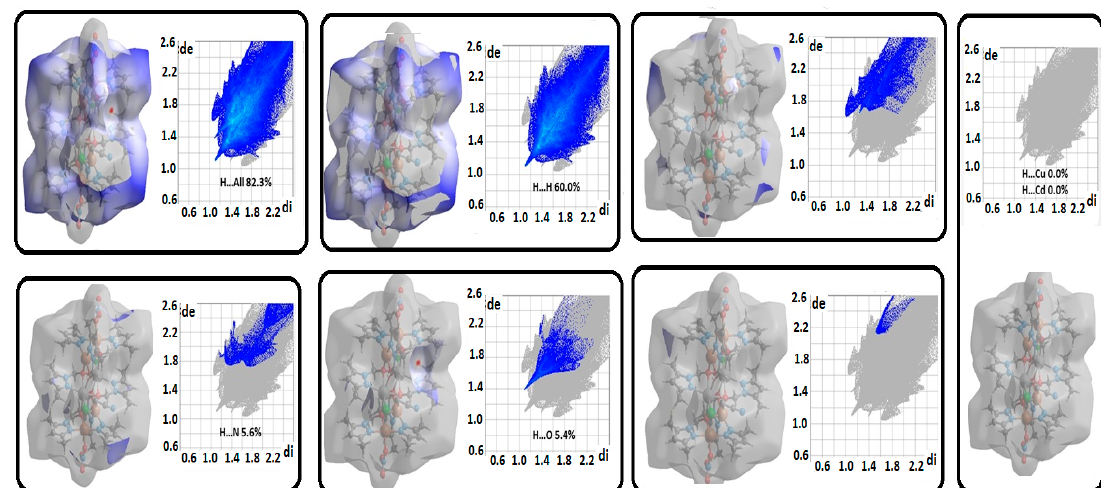
Figure 4. HSA-computed cluster structure together with 2D-FP and H….X% interaction ratios.